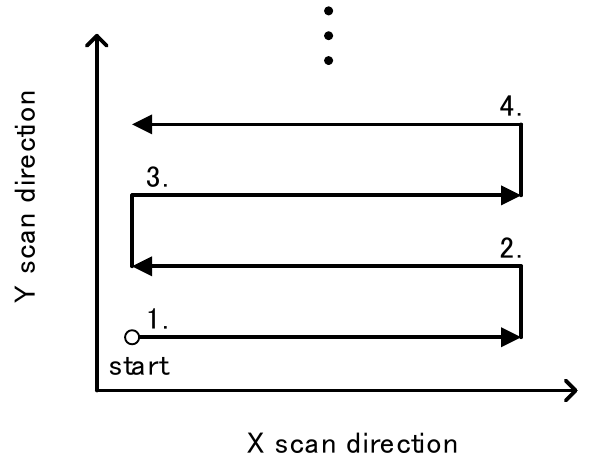
Figure 4. The trace of the two-dimensional scanning sequence.